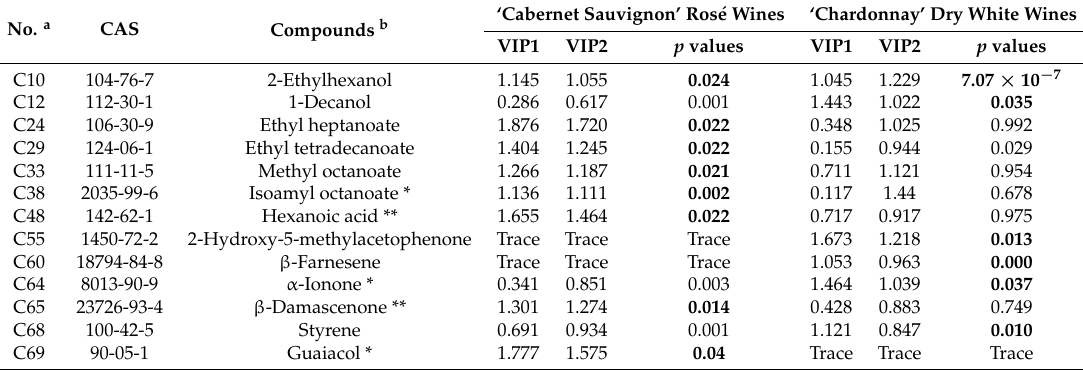
The data in bold were the most differentiated compounds (VIP>1, p < 0.05); a. The No. was in accordance with Table S2; b. * OAV > 0.1, ** OAV > 1.0.